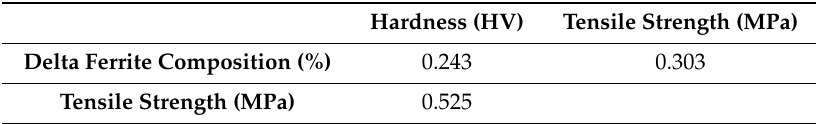
Table 8. Pearson correlation coe ffi cient between delta ferrite composition and mechanical properties of austenitic stainless steel at low annealing temperature (600–900 ◦ C).